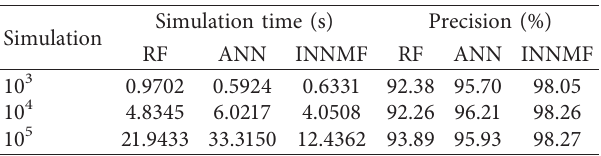
Table 3: Performance of aeroengine rotor vibration reliability